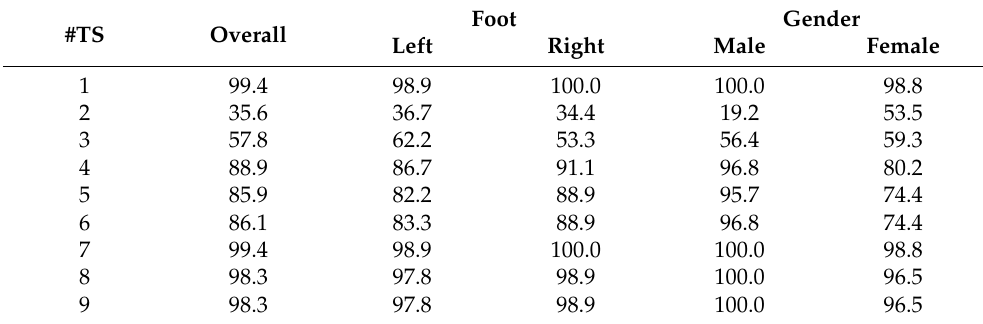
Table 1. Segmentation accuracy for each testing site (TS), calculated as the ratio between correctly identified sites over total sites, for a given site location. All values are presented in percentage (%). Foot Gender #TS Overall Left